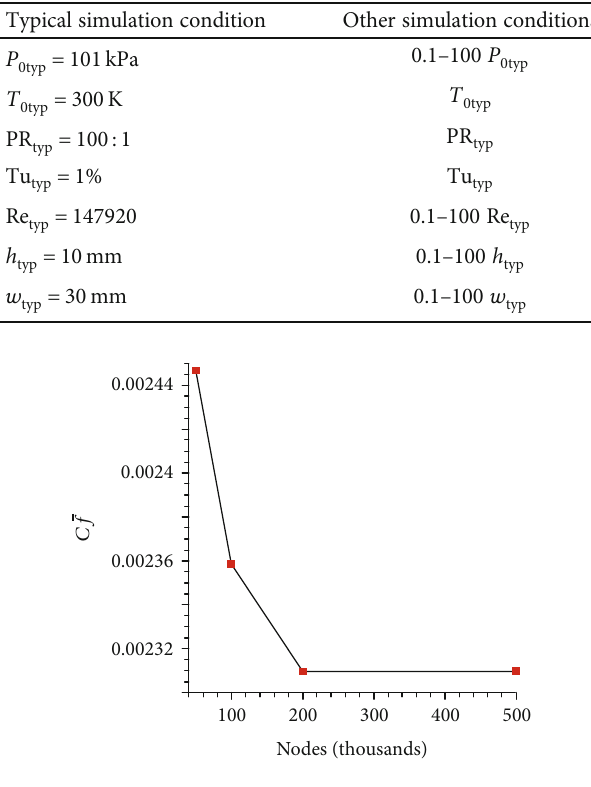
Figure 4: Grid dependency